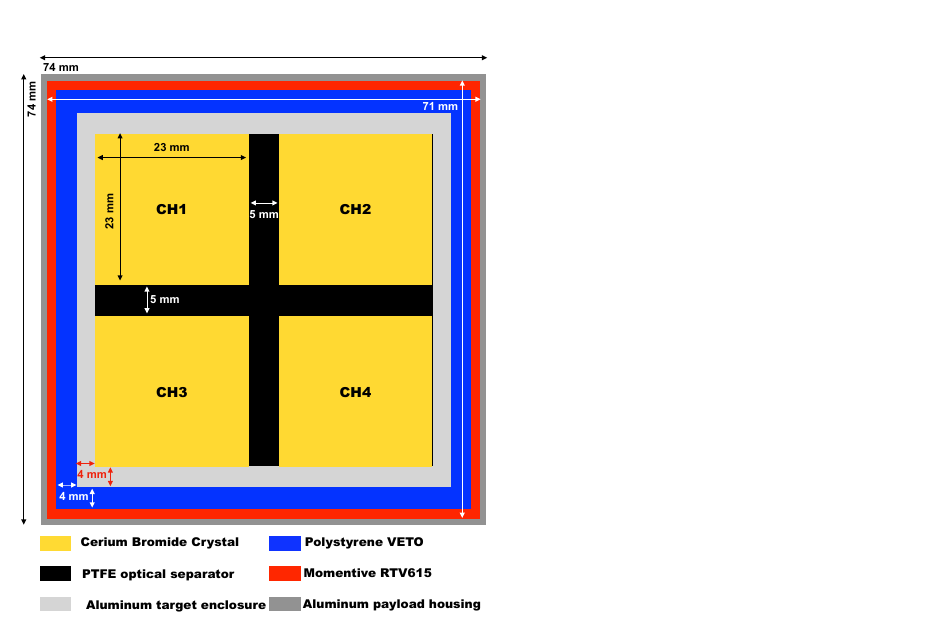
Figure 13. The cross section of the detector studied in the simulation. In yellow is the 4 CeBr 3 scintillating crystals [26] optically separated by means of a PTFE barrier (in black). The target is sealed by means of an aluminum enclosure (light gray). In blue is the polystyrene-based VETO for the rejection of charged particle induced events. In red is the Momentive RTV615 silicon used as electrical and thermal insulator. The whole assembly is ultimately enclosed in an outer aluminum box (dark